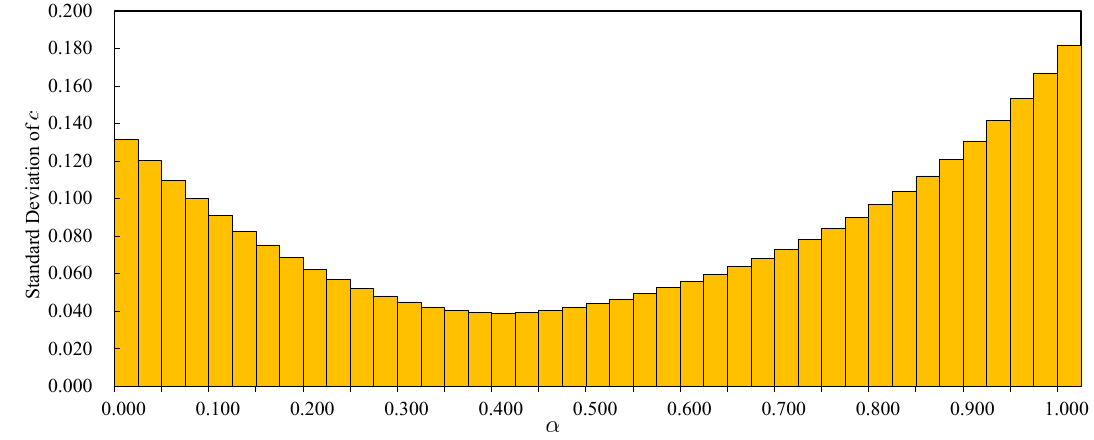
Figure 8 . The standard deviation of c = m tower / | Λ | α for each α in the case of anisotropic non- SUSY vacua. The range of α shown in the figure is set as [0 . 000 , 1 . 000] and the increments are 0.025. In this figure, α = 0 . 400 gives the minimum value 3 . 92 × 10 − 2